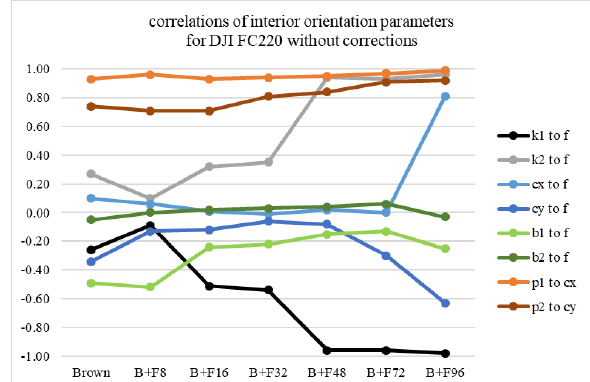
Figure 6. Resulting correlations of different interior orientation parameters for DJI FC220 (data set 4) of combined processed data sets 4+5.